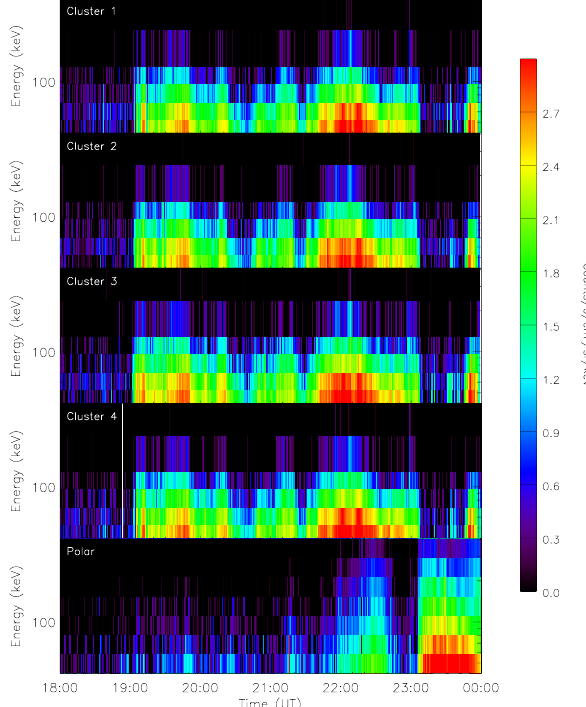
Fig. 14. First four panels: Cluster RAPID IES data for 1 September 2002 (18:00 to 24:00 UT interval). Bottom panel: Polar CEPPAD IES data for the same